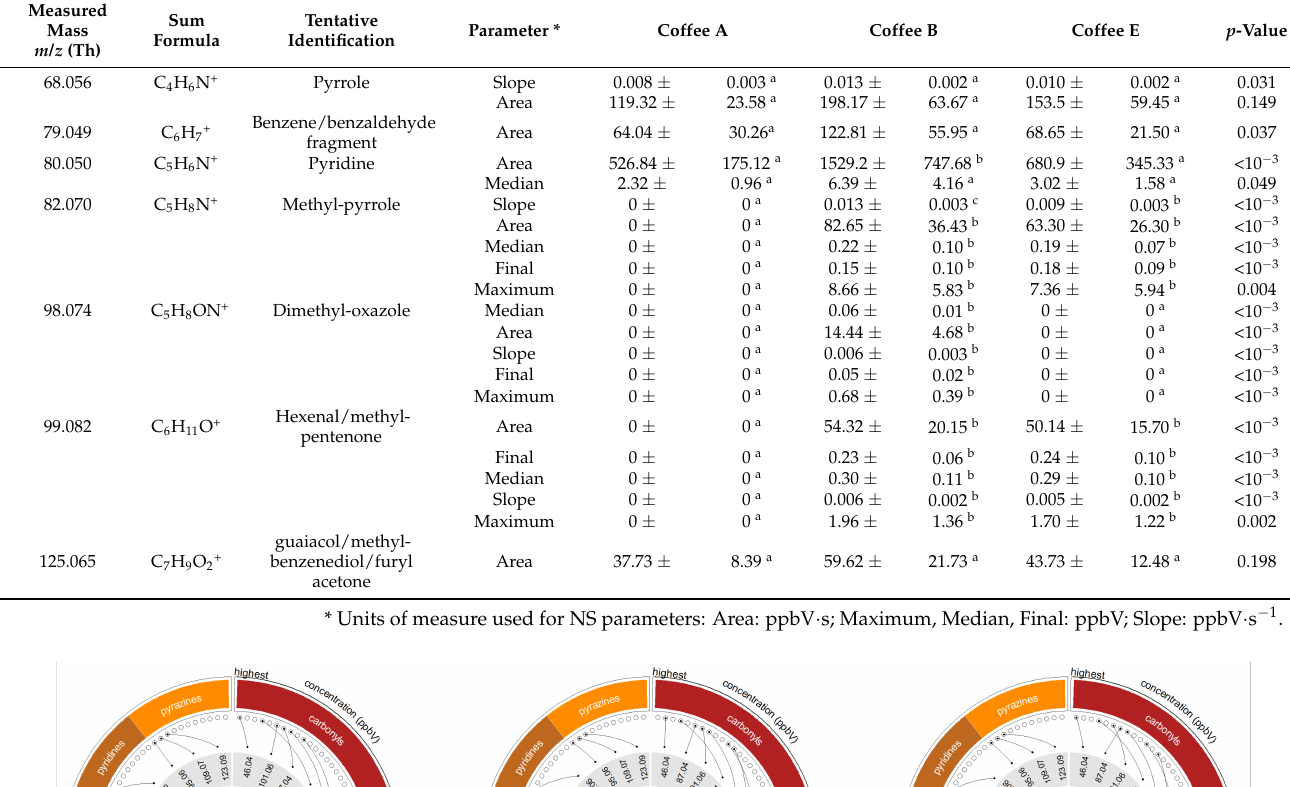
Table 3. Selected nosespace mass peaks and corresponding parameters (VIP > 1.5). Means and standard deviations are reported for each sample. p -values were obtained on the basis of one-way ANOVA and corrected, taking into account the false discovery rate. Superscript annotations are used to display differences between coffees; therefore, when two values are annotated by different letters, this denotes the pairwise statistically significant difference (Tukey’s HSD).